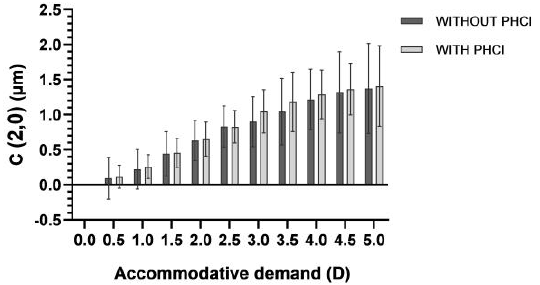
Figure 2. Defocus Zernike coefficients for the different target vergences, with and without phenylephrine (grey and black bars, respectively), calculated for the same 4 mm pupil diameter. Error bars represent the standard deviation (SD).